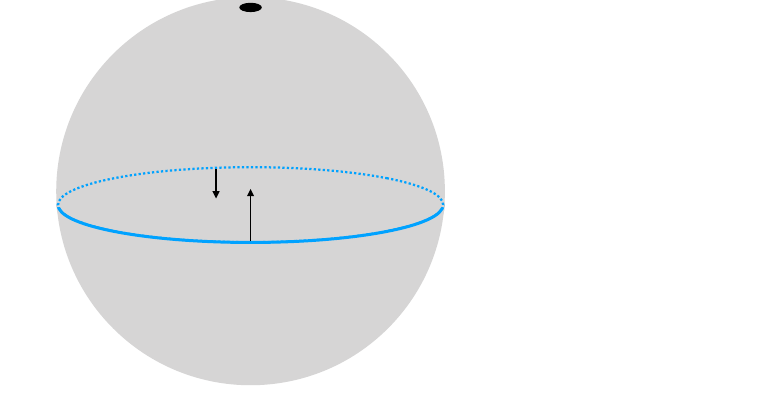
Figure 3 . A particle on a positively curved space. The centrifugal force is sometimes attractive and sometimes